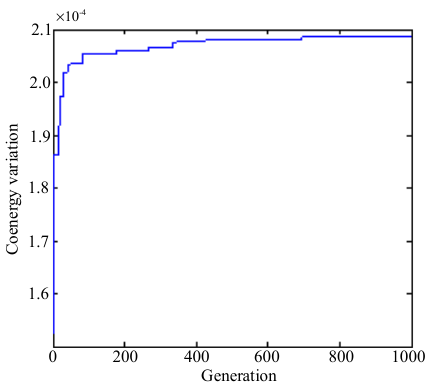
Figure 21. Evolution curve of the designed DSSRM.